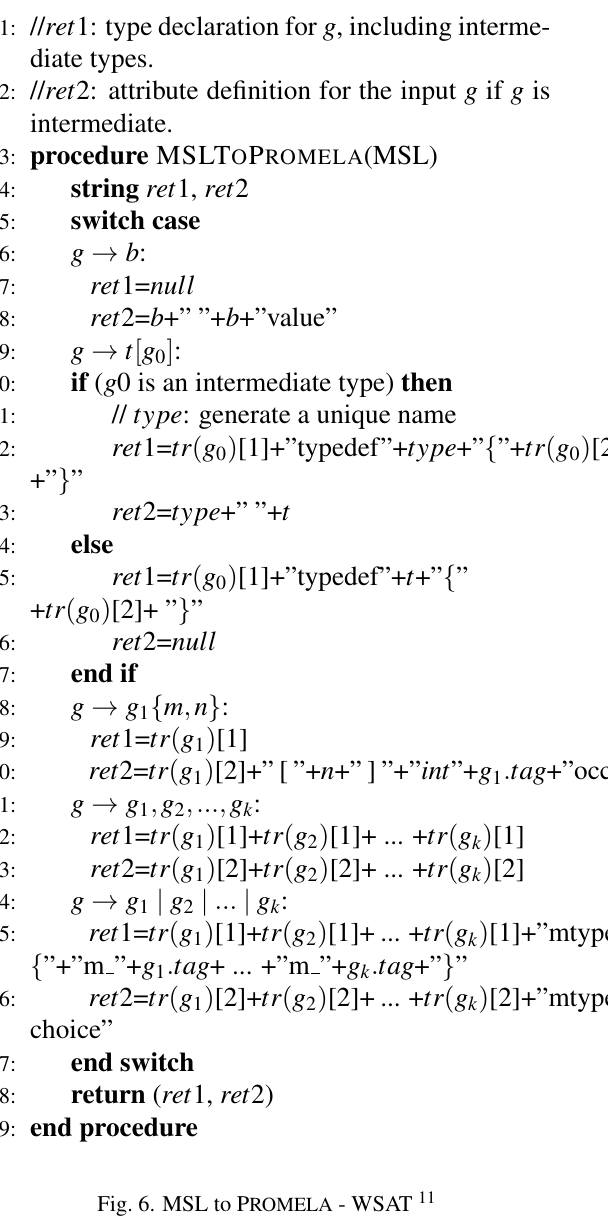
Fig. 6. MSL to P ROMELA - WSAT